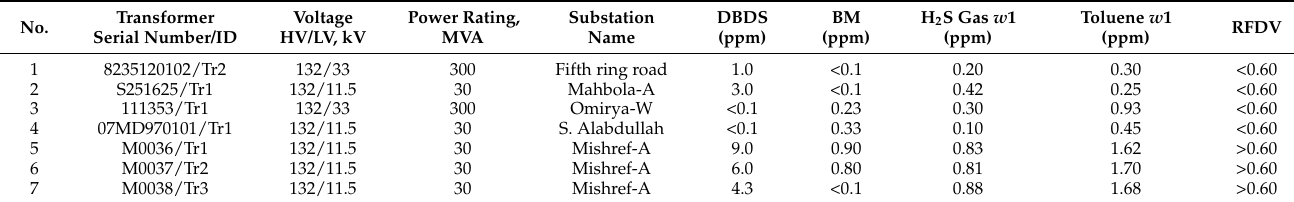
Table 2. Measured values of dibenzyl disulfide (DBDS), benzyl mercaptan (BM), hydrogen sulfide (H 2 S) gas, and toluene. RFDV is calculated according to Equation (2). The measured values are the average of three measurements. The average of Relative Standard Deviations (RSDs) for all was <4%. The uncertainty (U exp. ) of five measurements of hydrogen gas and toluene was ± 0.07 for mean value 0.50 ppm and ± 0.10 for mean value 1.93 ppm, respectively.